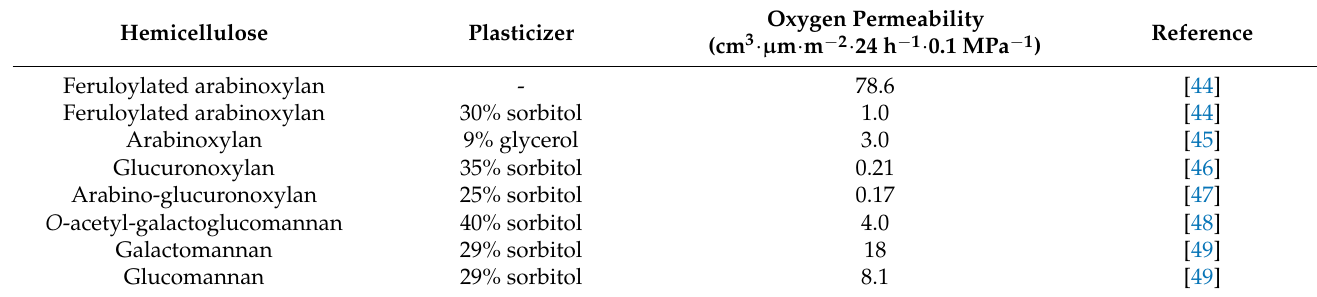
Table 2. Oxygen barrier properties of different hemicellulose-based composite